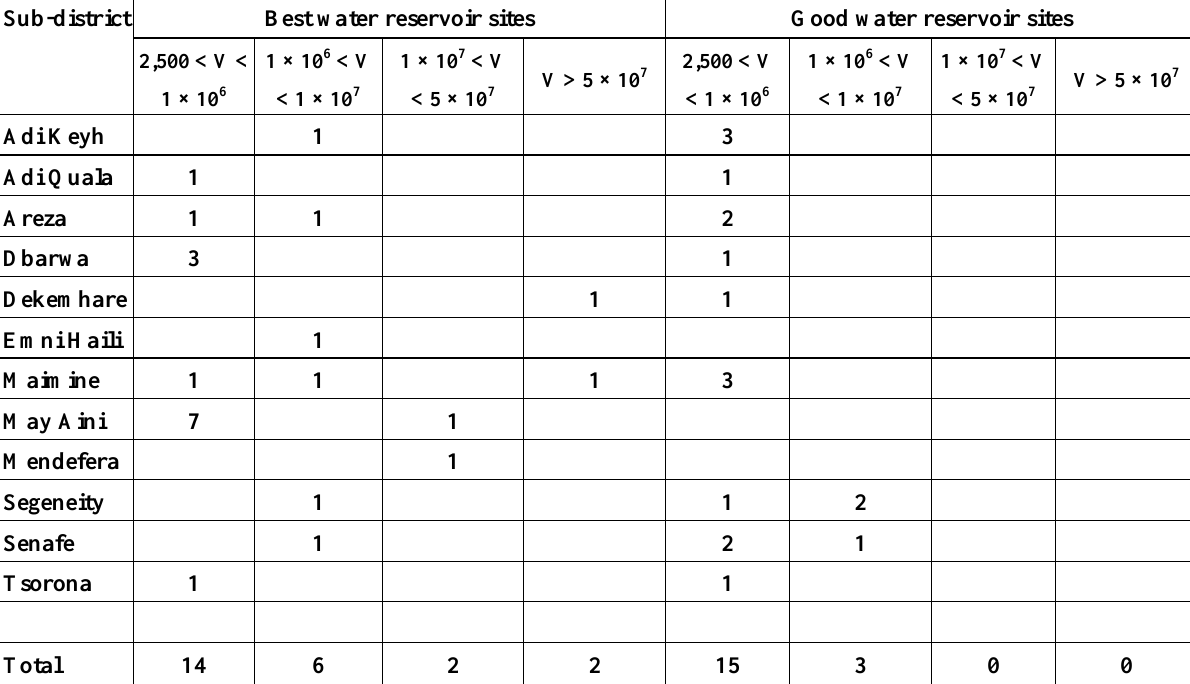
Table 17. Number of sites in each sub-district according to volume calculation.